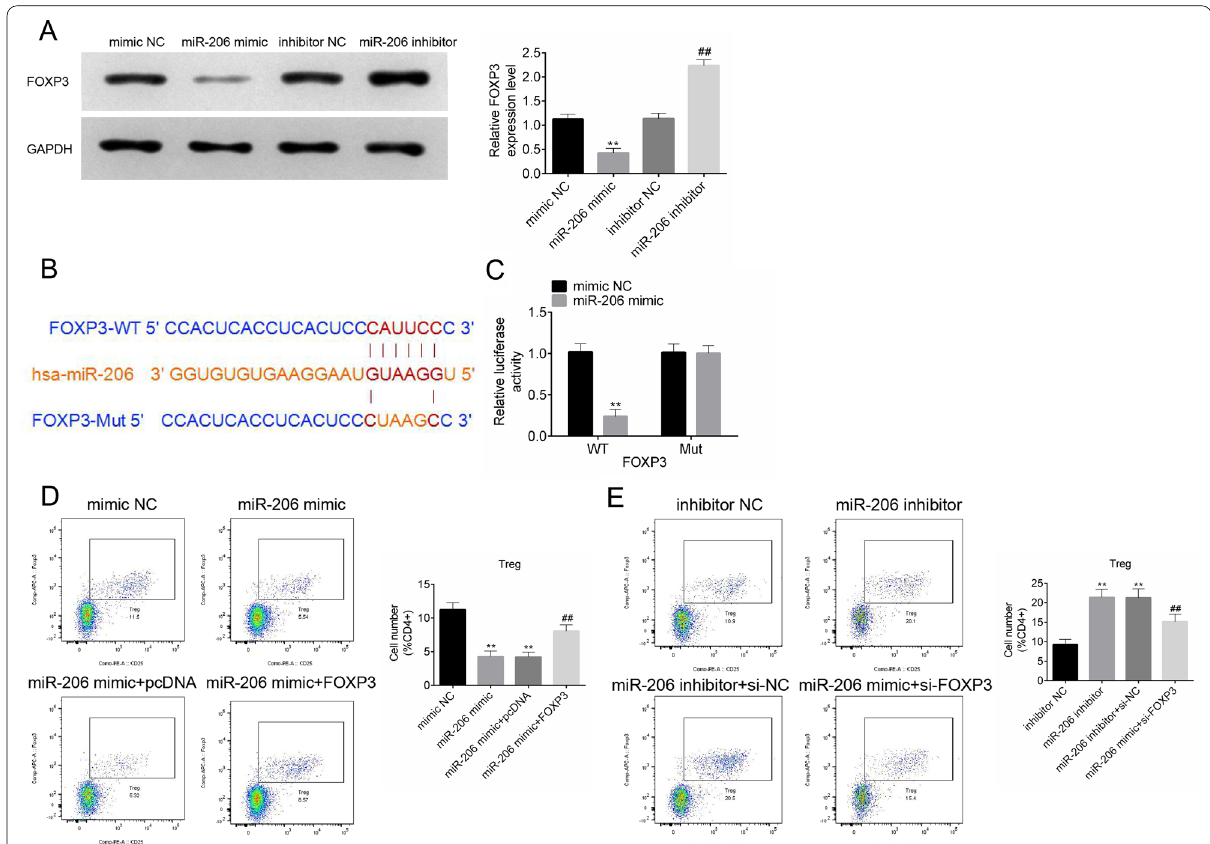
Fig. 3 MiR-206 inhibited the differentiation of Treg cells by decreasing Foxp3 expression. A Expression levels of Foxp3 in CD4 + T cells in response to miR-206 overexpression or knockdown. B , C Schematic illustration of miR-206 binding sites in Foxp3 and direct binding of miR-206 to Foxp3 by a dual luciferase reporter assay. D , E The percentage of Treg cells in CD4 + T cells in response to co-overexpression or co-knockdown of miR-206 and Foxp3. All experiments were repeated three times. Data are expressed as mean SD. ** P < 0.01; ## P < ±